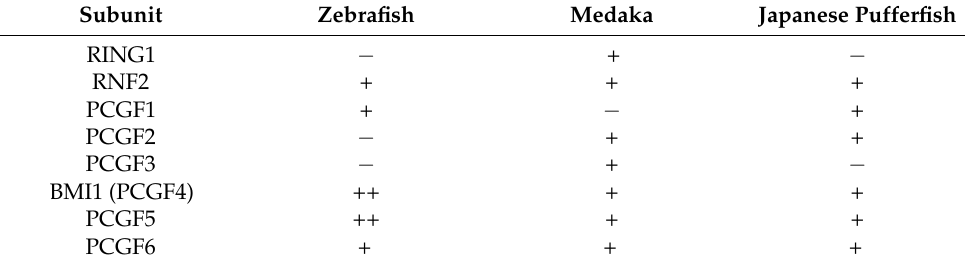
Table 2. The genes encoding PRC1 core subunits in the zebrafish ( Danio rerio ), the medaka ( Oryzia latipes ) and the Japanese pufferfish ( Tetraodon nigroviridis